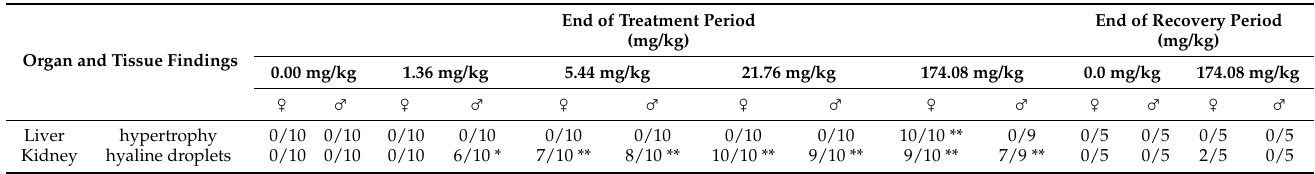
Table 5. Histopathological findings of SD rats orally administered AQ for 90 days.